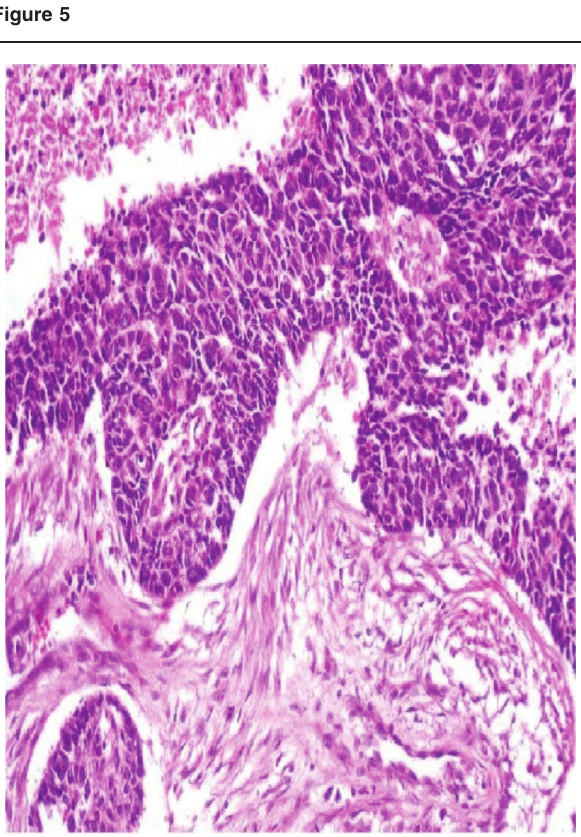
Photograph showing ultrasound Siemens Acuson, ×300.